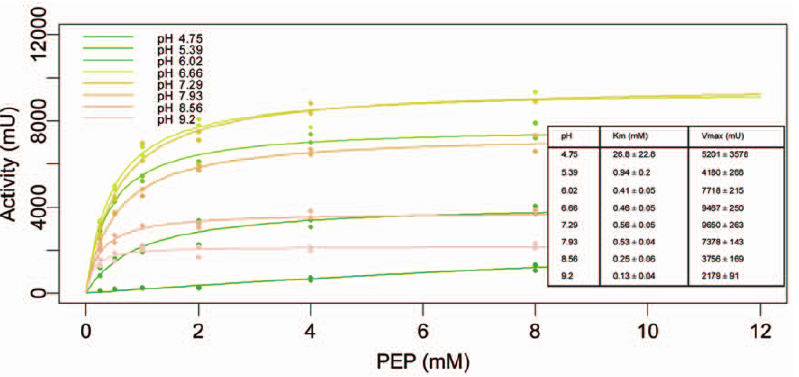
Figure 7. Substrate dependence of PYK activity at different pH-values and fitted Michaelis Menten curves. The small table in the figure shows the Michaelis Menten constants and their estimated uncertainties as determined by the fitting procedure. Note the pH dependent trend in Km and the drastically lower substrate-affinity at pH=4.75.